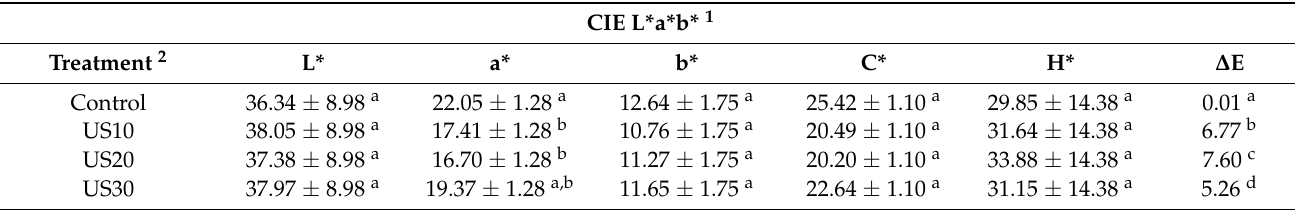
Table 1. Tukey HSD (honest significant difference) test for trichromatic variables of bovine Triceps brachii after ultrasound treatment at different